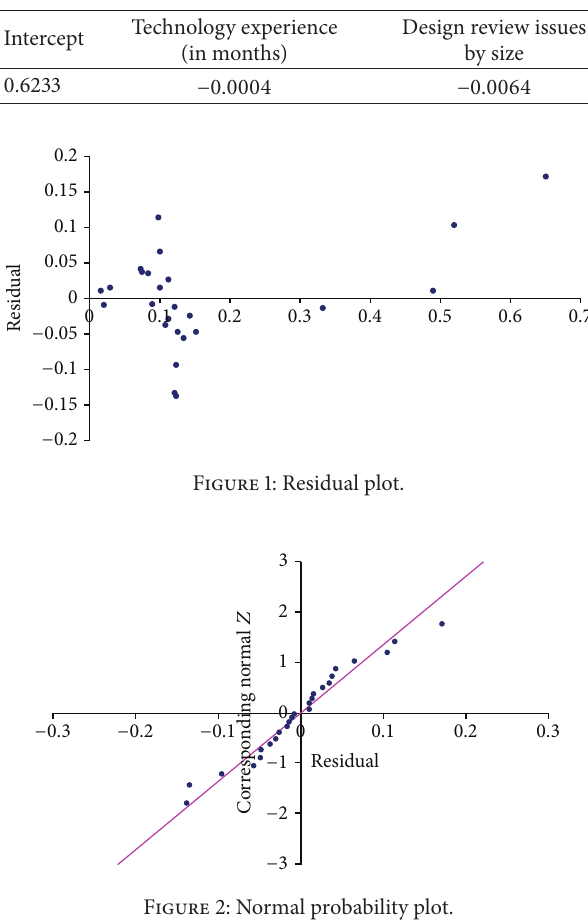
Table 1: Project data values. Table 2: Regression equation.